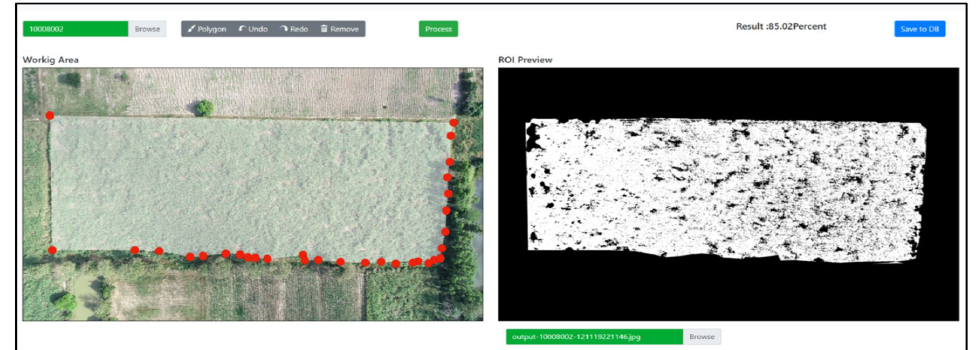
Figure 17. The result of defect detection process together with the graphical user